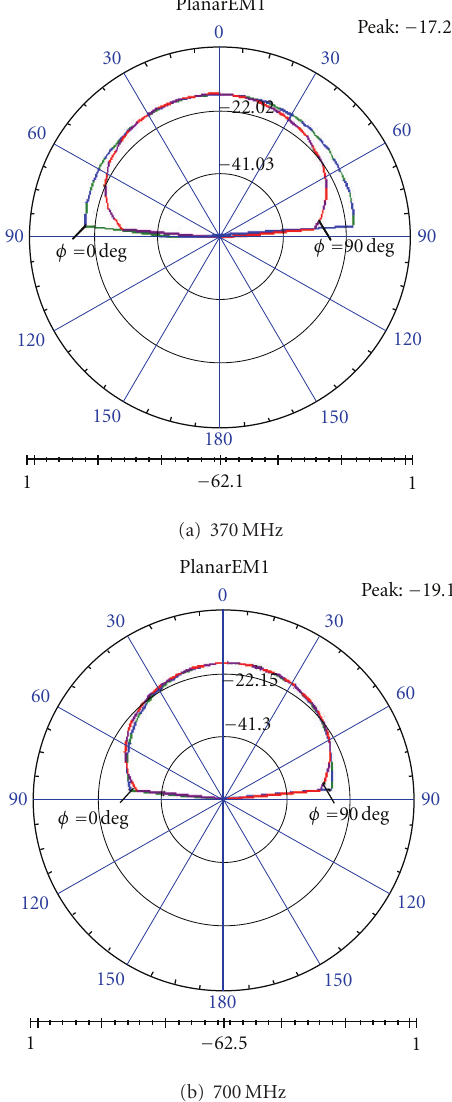
Figure 8: 2 D Radiation patterns at the select